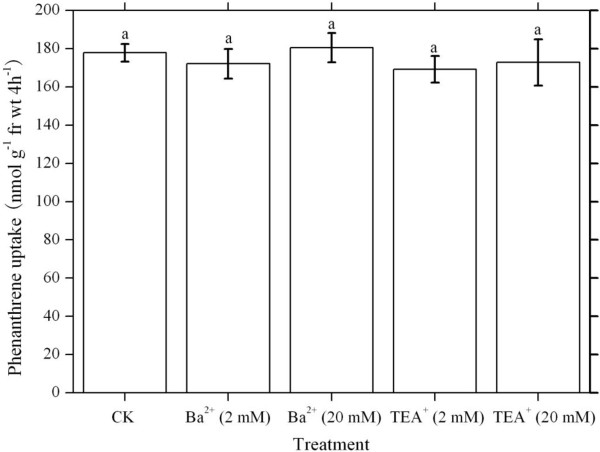
Uptake of phenanthrene in the presence or absence of blockers (TEA+ and Ba2+) for K+ channels. Hydroponic solution was Hoagland nutrient solution (pH 5.5) with 5.62 μM phenanthrene. Each histogram bar represents the mean value of triplicates. Bars are the standard deviation of the mean. Data were subjected to one-way ANOVA and compared using the Duncan’s test (P < 0.05). The same letters above the error bars indicate no significant differences. fr wt, Fresh weight. TEA+, Tetraethlyammonium.